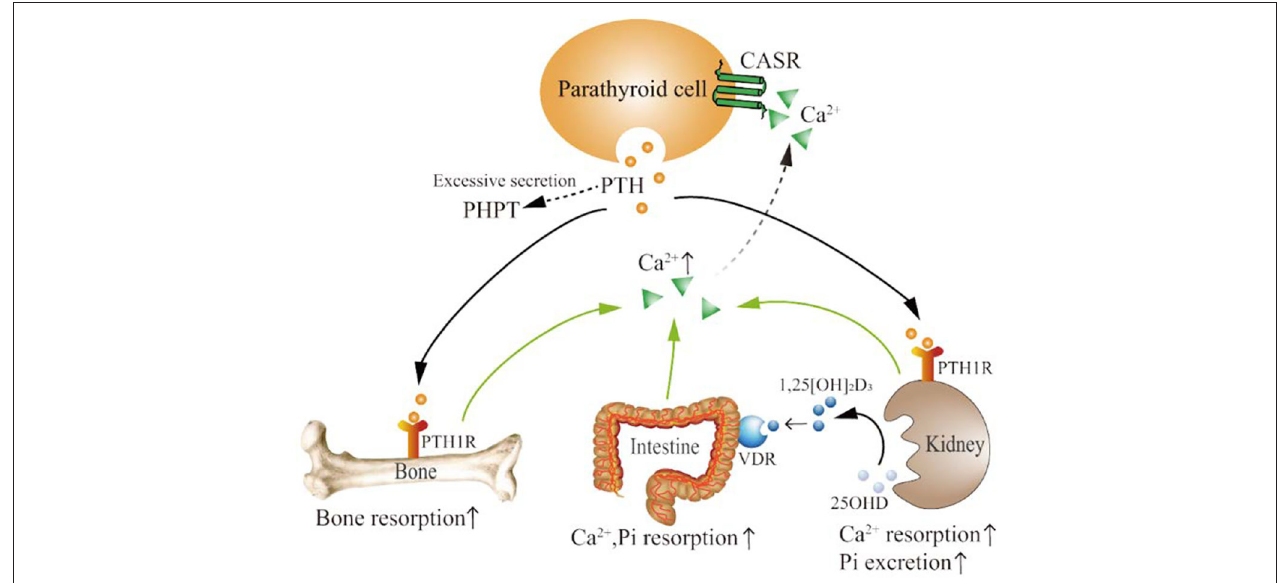
FIGURE 2 | The physiological mechanism of PTH action. PTH is secreted by parathyroid cells. Excessive PTH secretion can cause PHPT. PTH functions by binding to the PTH1R in bone and kidney. PTH promotes bone absorption and the release of bone Ca 2 + , as well as the reabsorption of Ca 2 + and the excretion of Pi in the kidney. PTH can also promote the conversion of 25OHD to 1,25[OH] 2 D 3 in the kidney. 1,25[OH] 2 D 3 binds to VDR, increasing the reabsorption of Ca 2 + and Pi in the intestine. Serum Ca 2 + regulates PTH secretion by binding to CASR on parathyroid cells. PTH, parathyroid hormone; PHPT, primary hyperparathyroidism; PTH1R, PTH1 receptor; Ca 2 + , calcium ions; Pi, phosphorus; 25OHD, 25-hydroxyvitamin D; 1,25[OH] 2 D 3 , 1,25-dihydroxyvitamin D; VDR, vitamin D receptor; CASR, calcium-sensitive receptors; ↑ ,